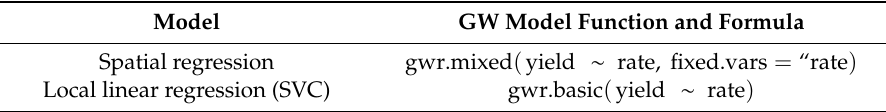
Table 1. Model forms tested as part of model